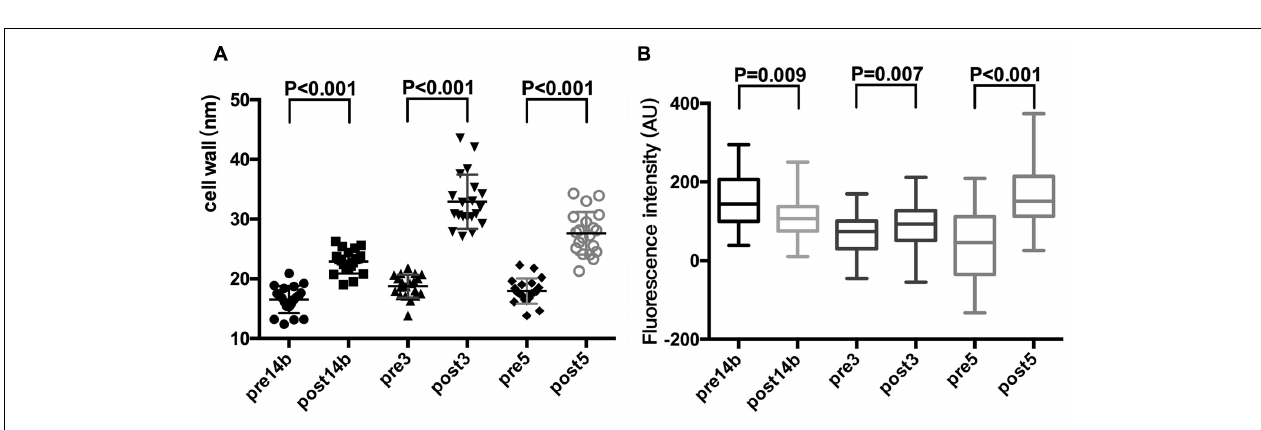
FIGURE 3 | Cell wall thickness (A) and fluorescence intensity of the cell membrane (B) of S. aureus wild and mutant strains. Thickness and fluorescence intensity were statistically analyzed with independent t